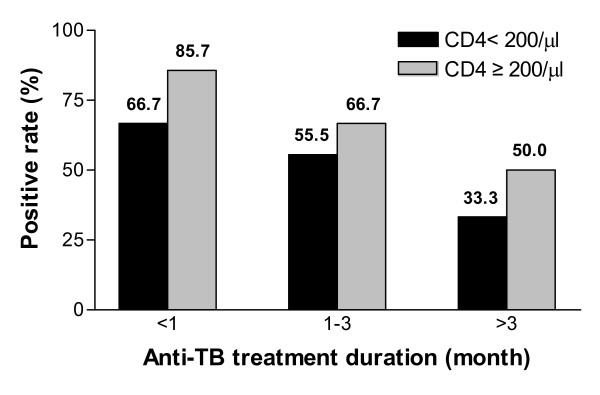
T-SPOT.TB positive rates in patients with active TB by different durations of TB treatment and CD4+ T cell counts. The black column represents the T-SPOT.TB positive rate of patients with CD4+ T cells <200/μl, and the gray column represents that of patients with CD4+ T cells ≥200/μl. There are decreasing tendency of T-SPOT.TB positive rate with increasing treatment duration in both CD4+ T cells ≥200/μl and CD4+ T cells <200/μl subgroups. But P > 0.05 between subgroups of different treatment durations and subgroups of different CD4+ T cell counts.